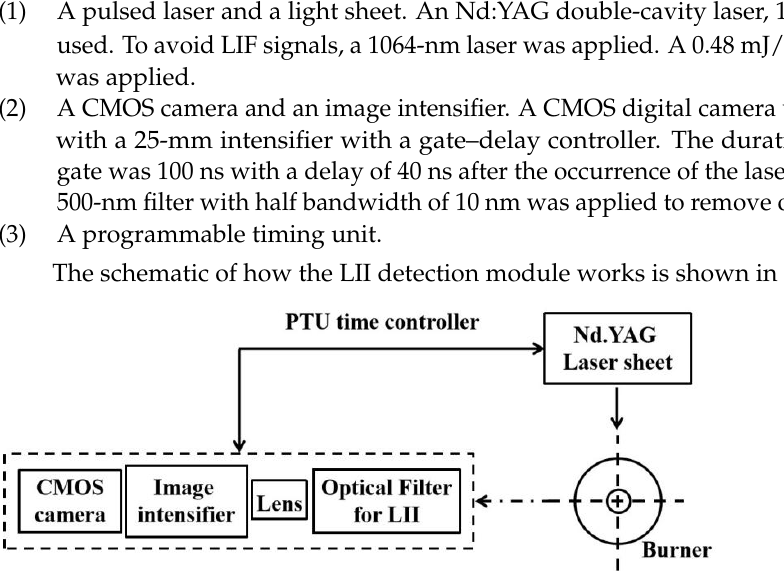
Figure 1. A schematic of the LII components. The LII theory was briefly introduced. The proper sheet laser source irradiated the flame; then, the soot inside the flame was heated to incandescence. The incandescence signal was captured by the CMOS camera through the image intensifier. The intensities at each point were marked as a count number range from 0 to 4095. The interval count value was determined by the camera. The soot volume fraction contour was represented by different count values. Visible flame images were captured using another high-quality CMOS digital camera (model number: JVC GC-P100). The aperture and the exposure time were set to F 4.5 and 1/200